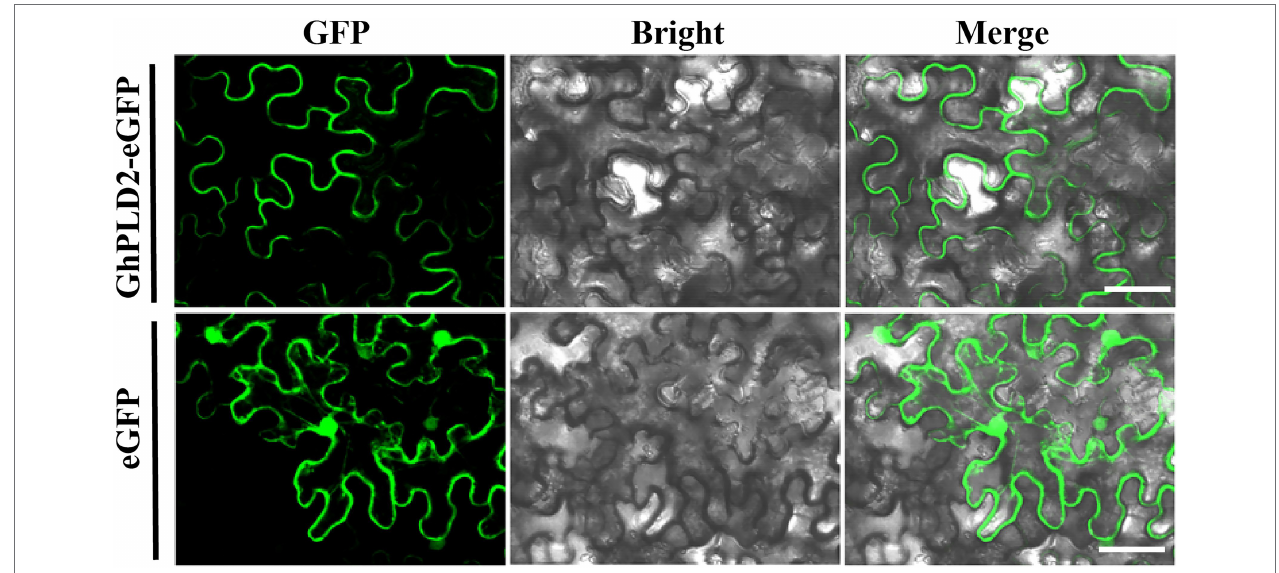
FIGURE 3 | Subcellular localization of GhPLD2 in tobacco ( Nicotiana benthamiana ) leaves. Subcellular localization of GhPLD2. Fluorescence signals from the GhPLD2-eGFP construct were mainly detected at the plasmalemma, while those of empty vector eGFP were detected in the nucleus, cytoplasm, and plasmalemma. Scale bar = 50 μ